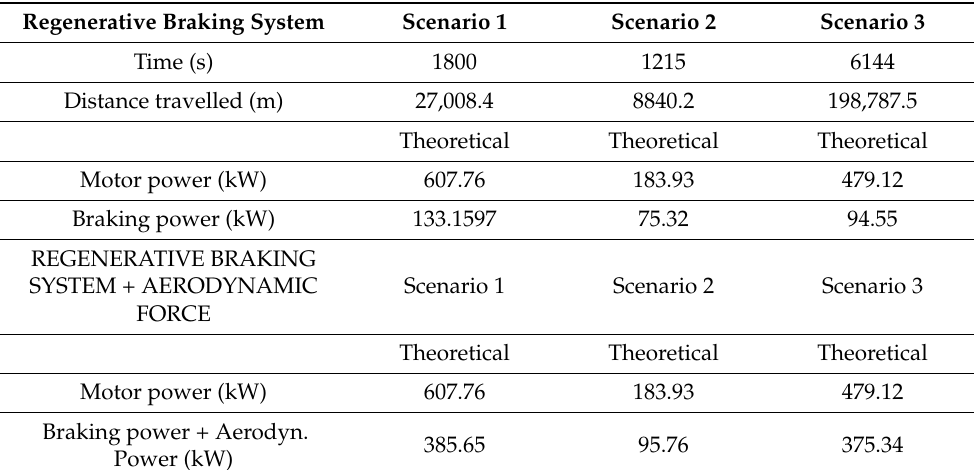
Table 6. Motor power and dissipated power in kW.